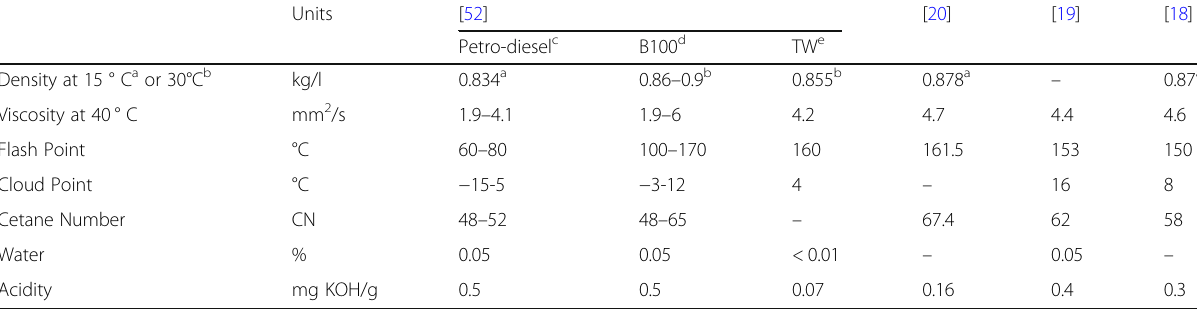
Table 3 Comparison of studies involving biodiesel from tannery waste, petro-diesel, and B100